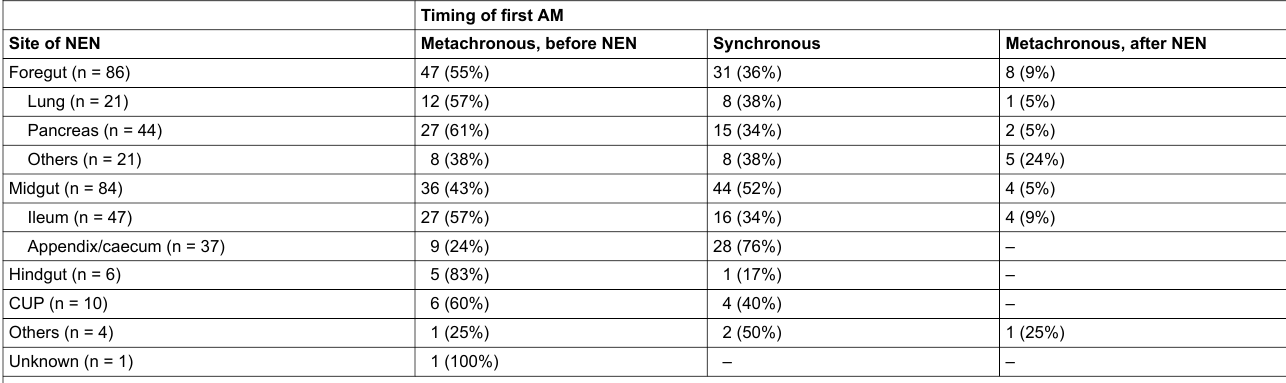
Table 5: Site of neuroendocrine neoplasm and timing of first additional